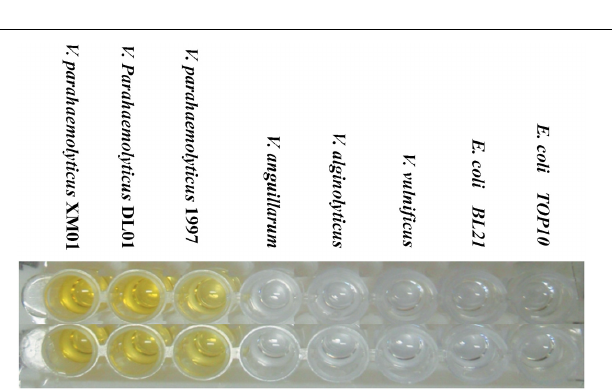
FIGURE 5 | Western blotting and affinity determination. (A) Western blotting analysis of the binding activity of scFv obtained by Skp co-expression to the TLH antigen. Left panel: SDS-PAGE results for the extracted TLH; Lane M: Protein molecular weight markers; Lanes 1, 2: extracted TLH. Right panel: Western blotting results; Lanes 3, 4: TLH band at 47kDa bound by scFv obtained by Skp co-expression. (B) Specificity analysis of scFv obtained by Skp co-expression. BSA, KLH, and associated antigen proteins (VP1668 and YscF) of V. parahaemolyticus were coated on